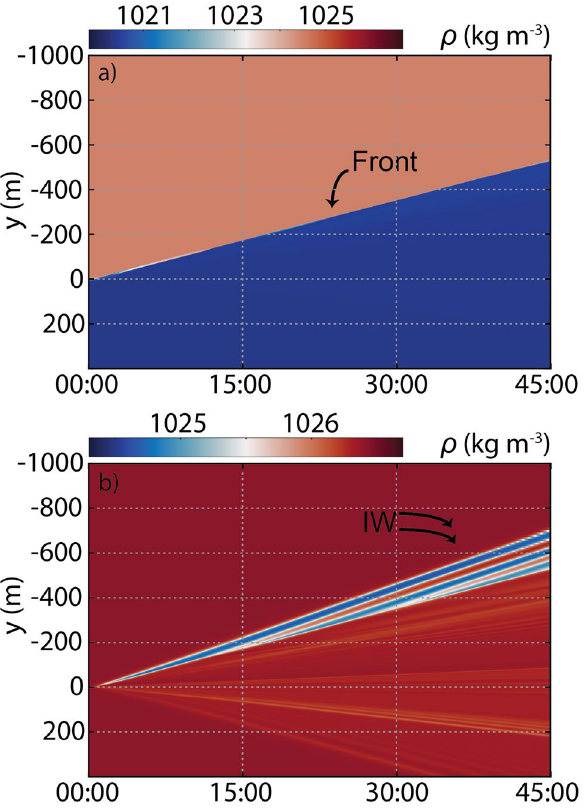
Figure 4. Plume front and IW velocities. Hovmöller diagram generated from model results from run #1 at the surface to highlight the front progression ( a ), and at 3.5 m depth to focus on internal solitary wave’s progression ( b ).